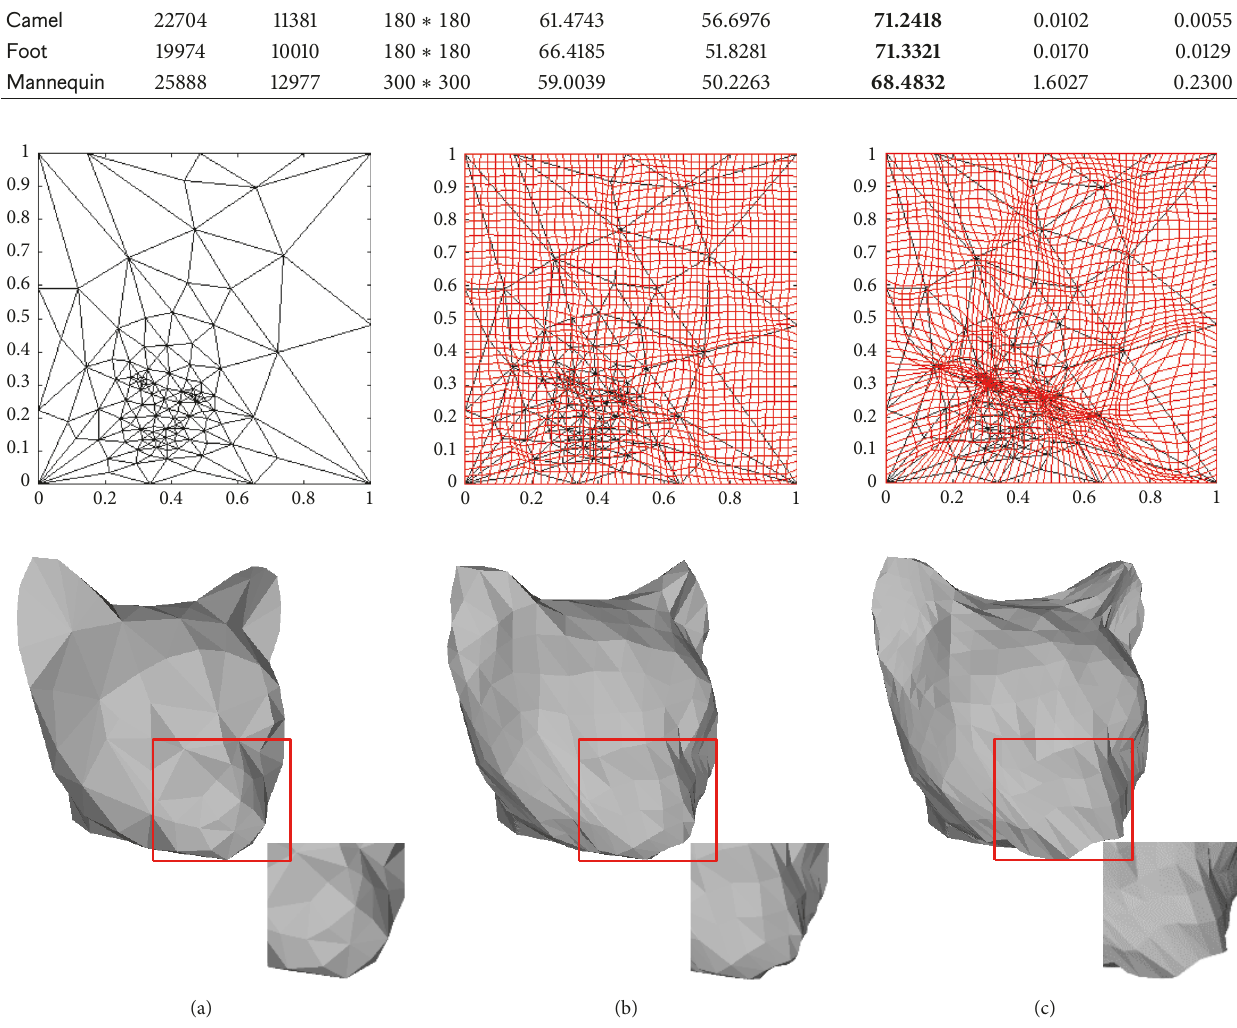
Figure 8: Adaptive sampling for different times of adjustment. From (a) to (c) are original mesh, reconstruction mesh after twice adaptive sampling, and reconstruction mesh after 15 times of adaptive